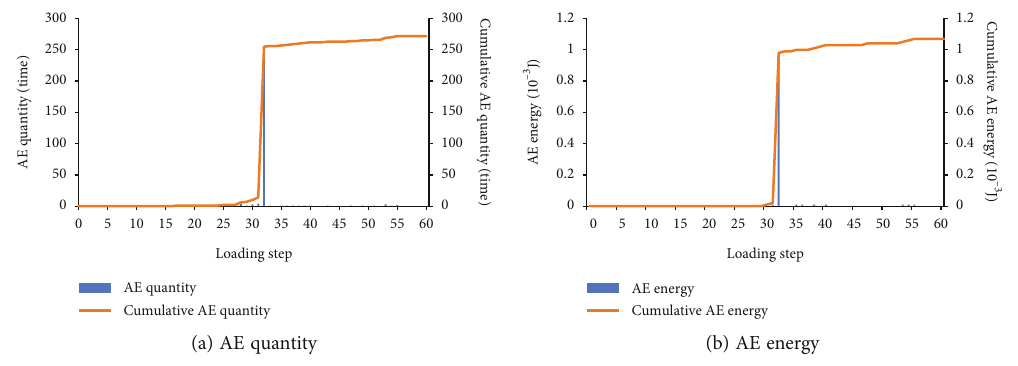
Figure 12: AE change curve when the distance a is